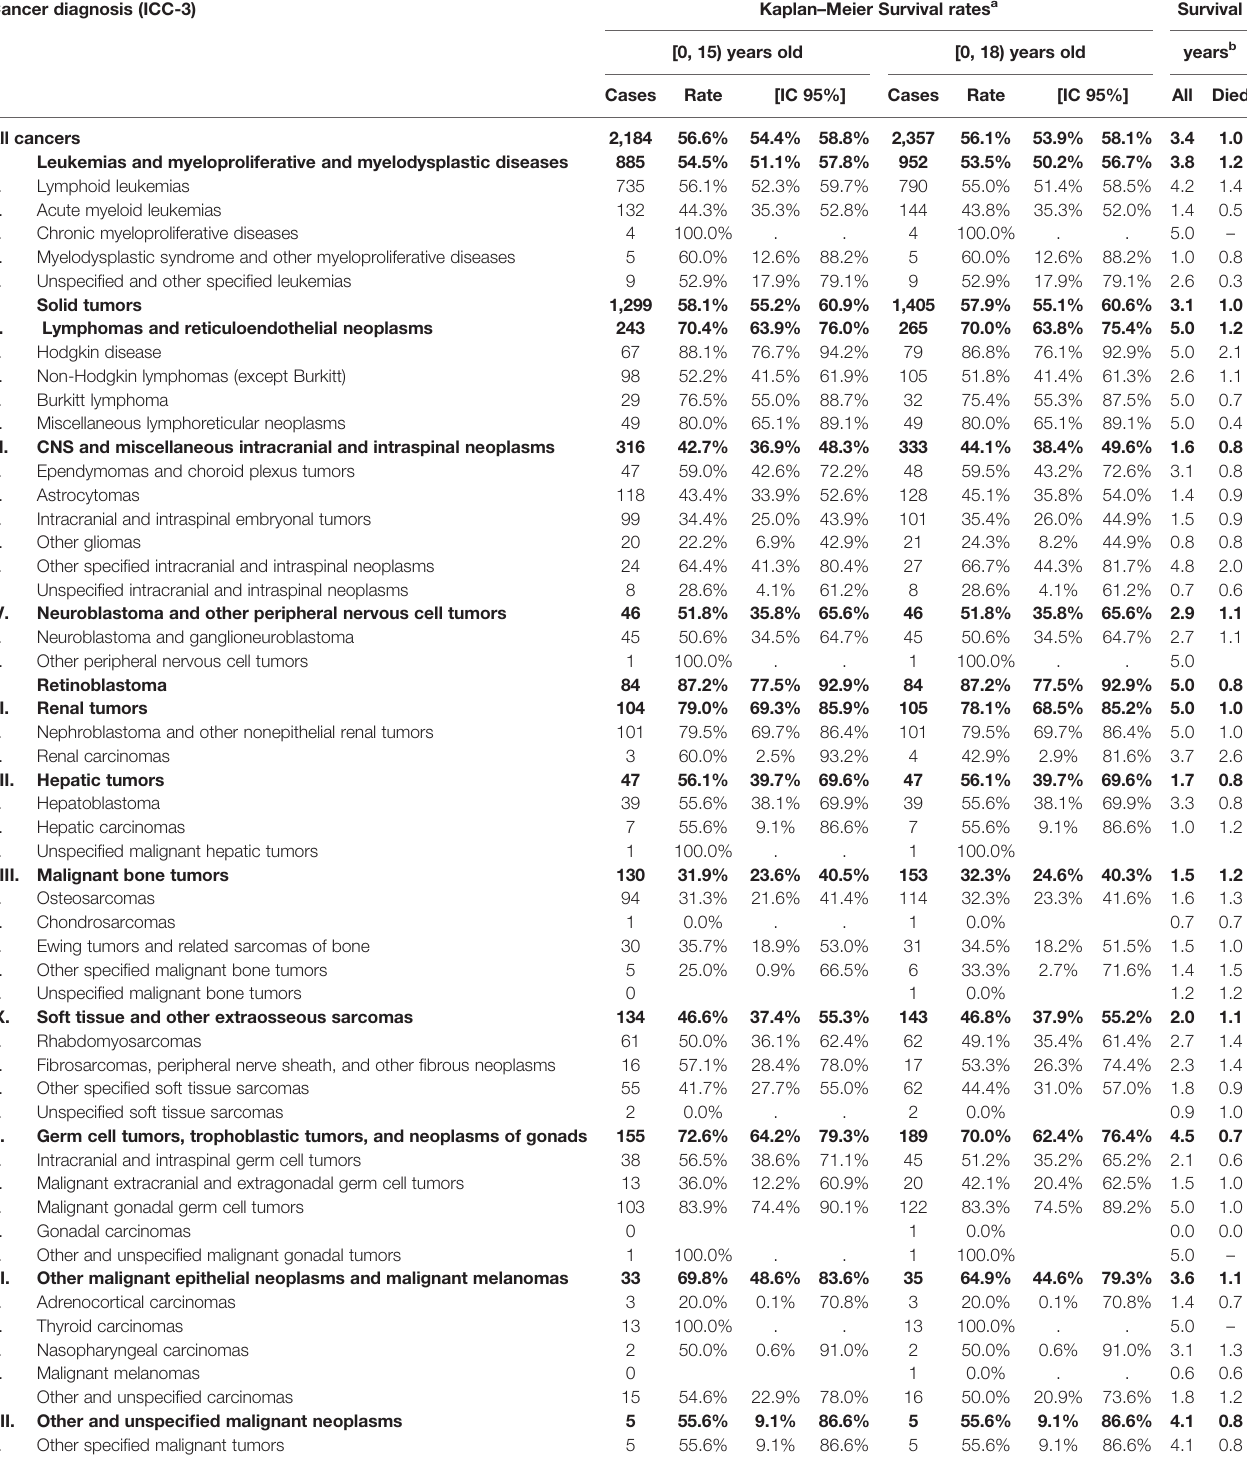
TABLE 2 | Five-year survival rate for childhood cancer in Mexican population 2006 – 2012. Cancer diagnosis